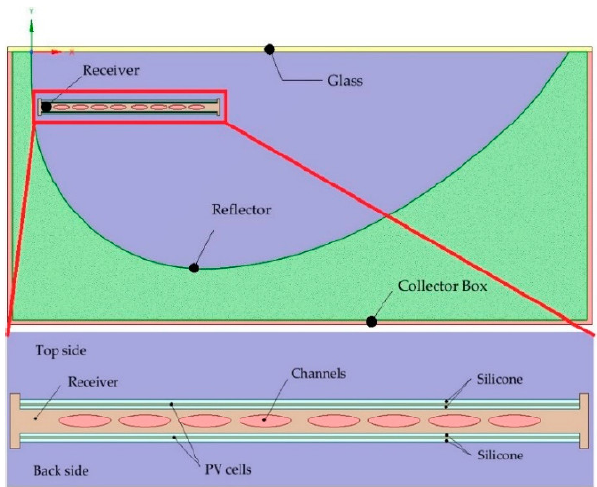
Figure 18. The cross-sectional view of the CPVT system and heat receiver tested in [101].